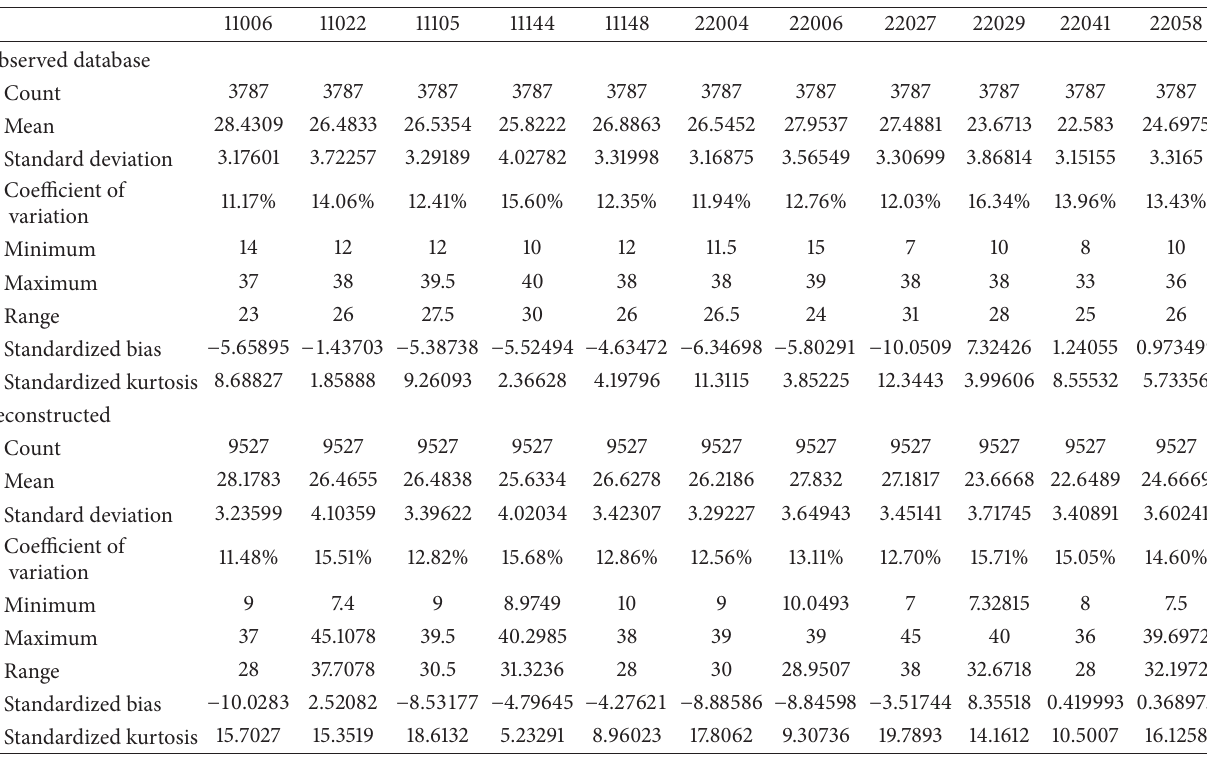
Table 2: Statistics of observed and reconstructed temperature data.